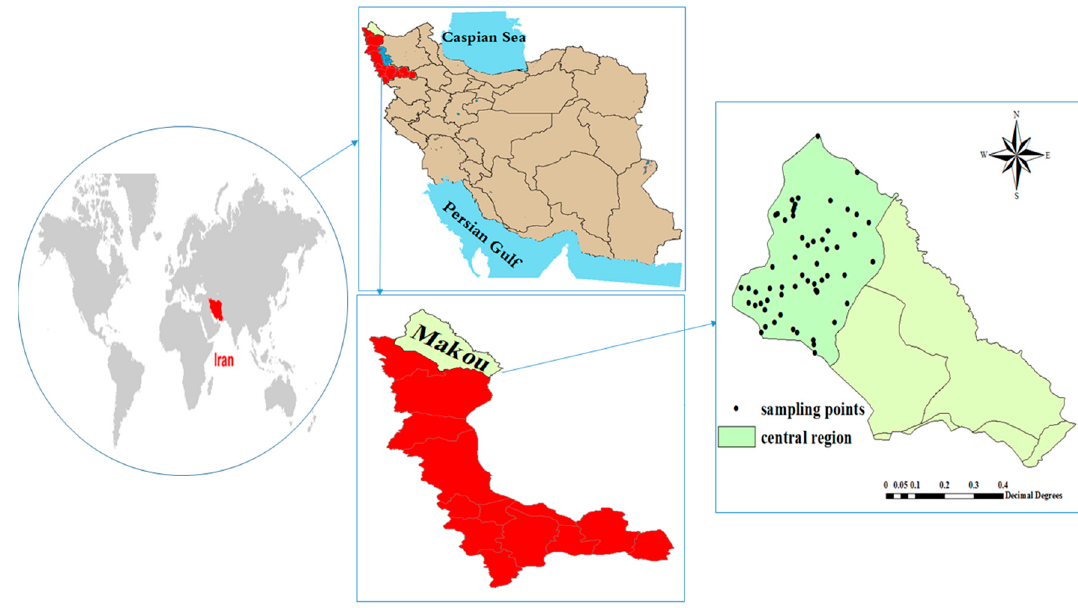
Figure 1. Study area and sampling location.